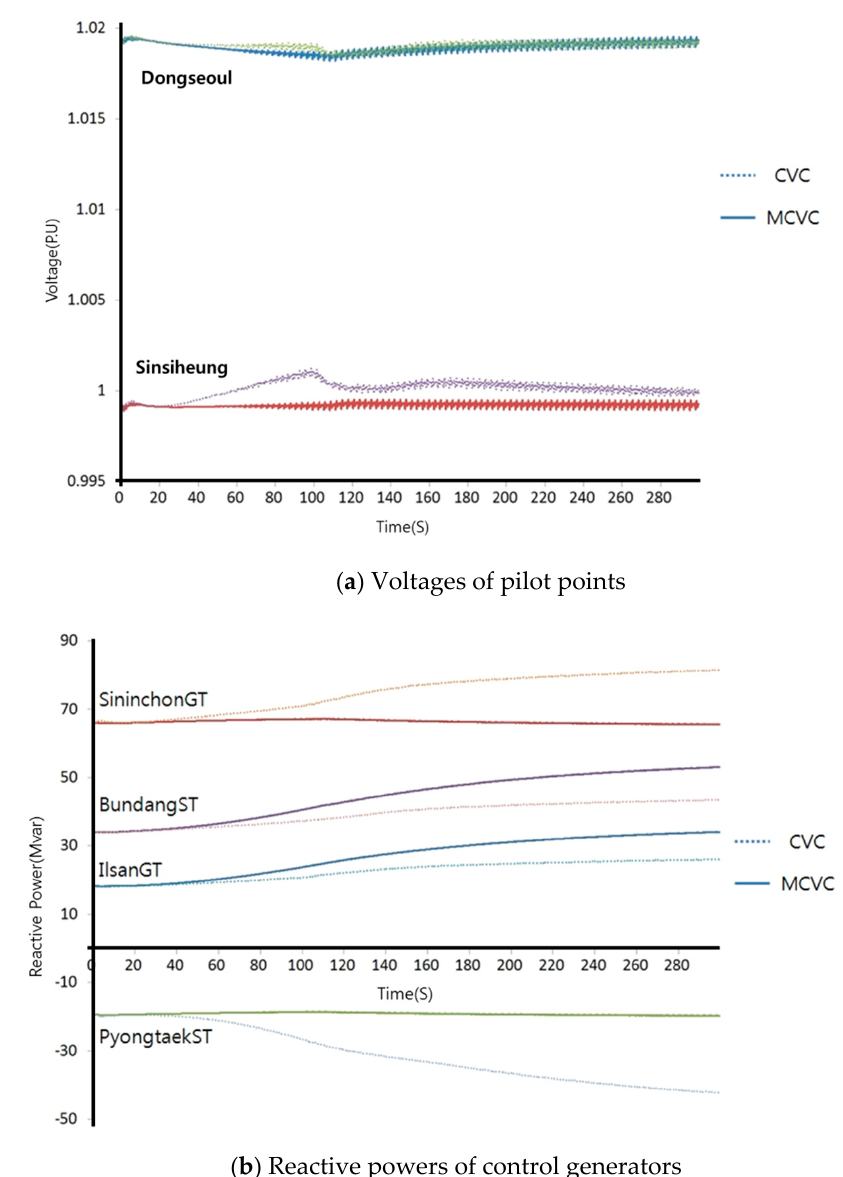
Figure 15. Result of load increase at the interface line.